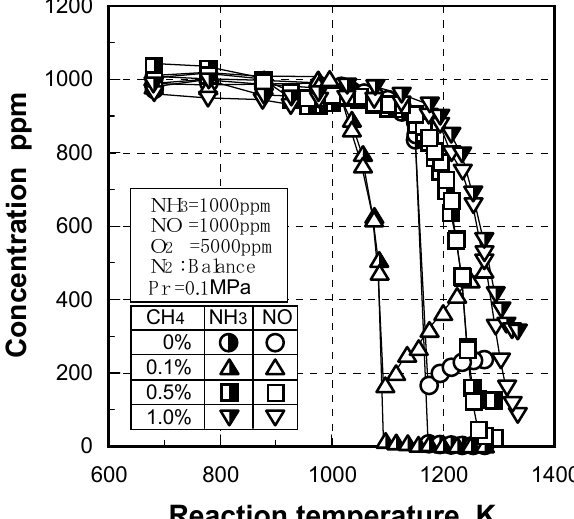
Figure 44. Effect of CH concentration on temperature as defined by 4